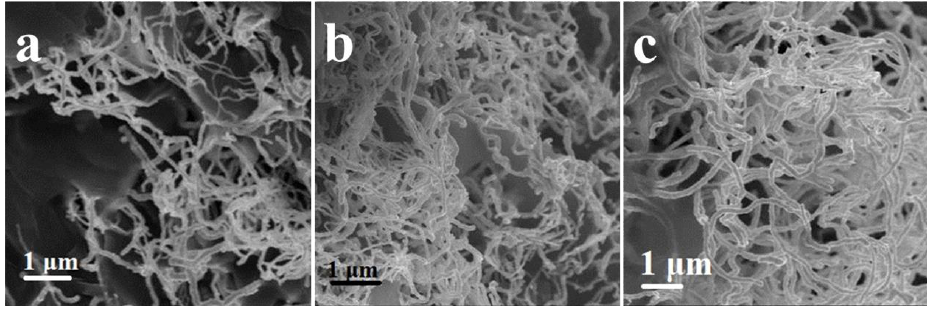
Figure 6. The SEM images of Au-Ag NWs synthesized at ( a ) 30 °C; ( b ) 60 °C; ( c ) 90 °C.